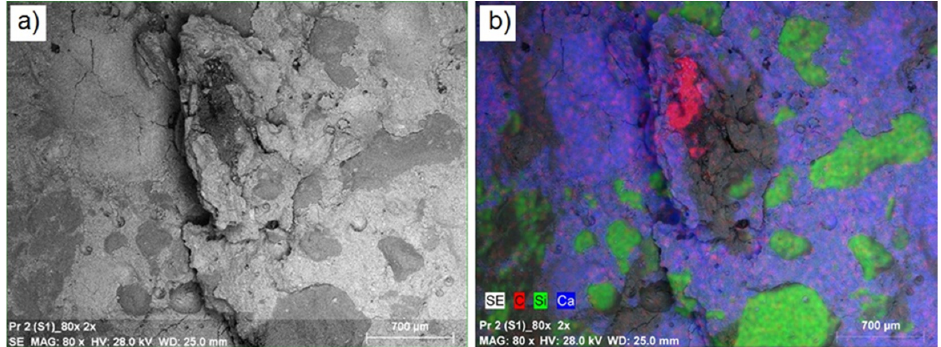
Figure 5. Concrete microstructure S1 series: ( a ) magnification 80 times; ( b ) a map of the location of dominant elements.